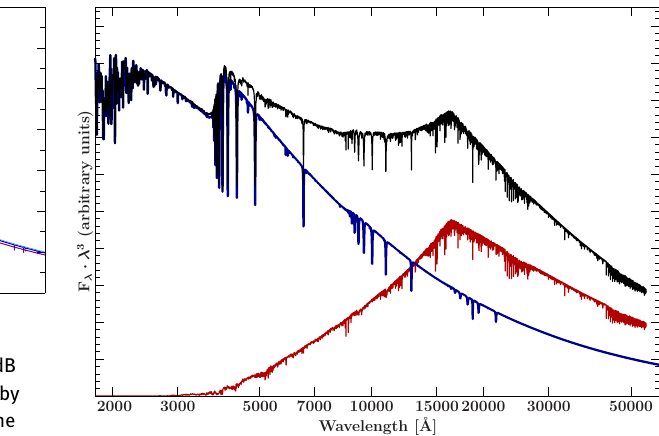
Figure 5. Synthetic SED for a composite-spectrum sdB binary. The sdB model (blue) is computed with ATLAS12 for T eff =30000K. The flux distribution of the cool companion (red) is taken from the PHOENIX grid for a T eff =5000K (Husser et al.